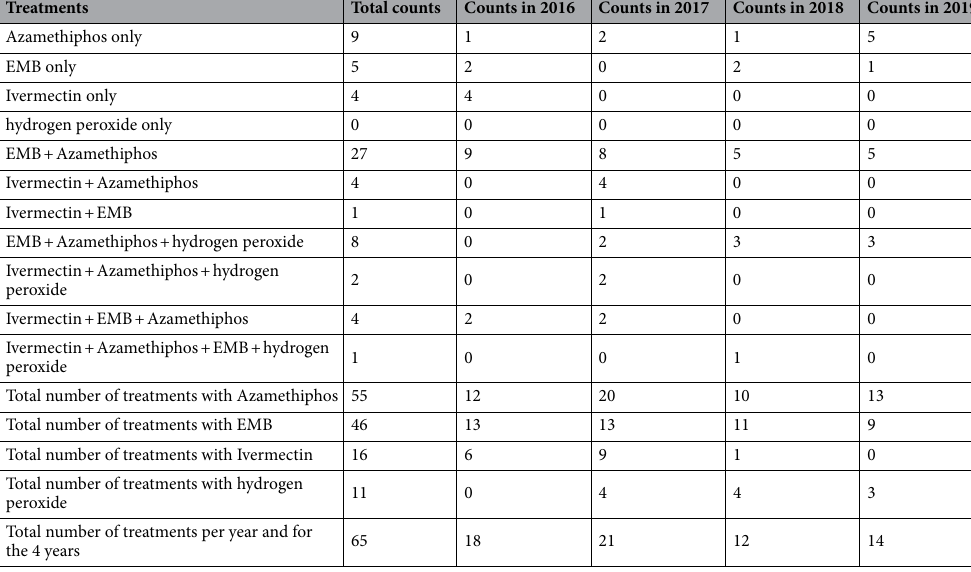
Table 1. Counts of treatments per year at sites ( n = 29) where anti-sea lice medications and/or successions of chemotherapeutants were used from 2016 to 2019 in